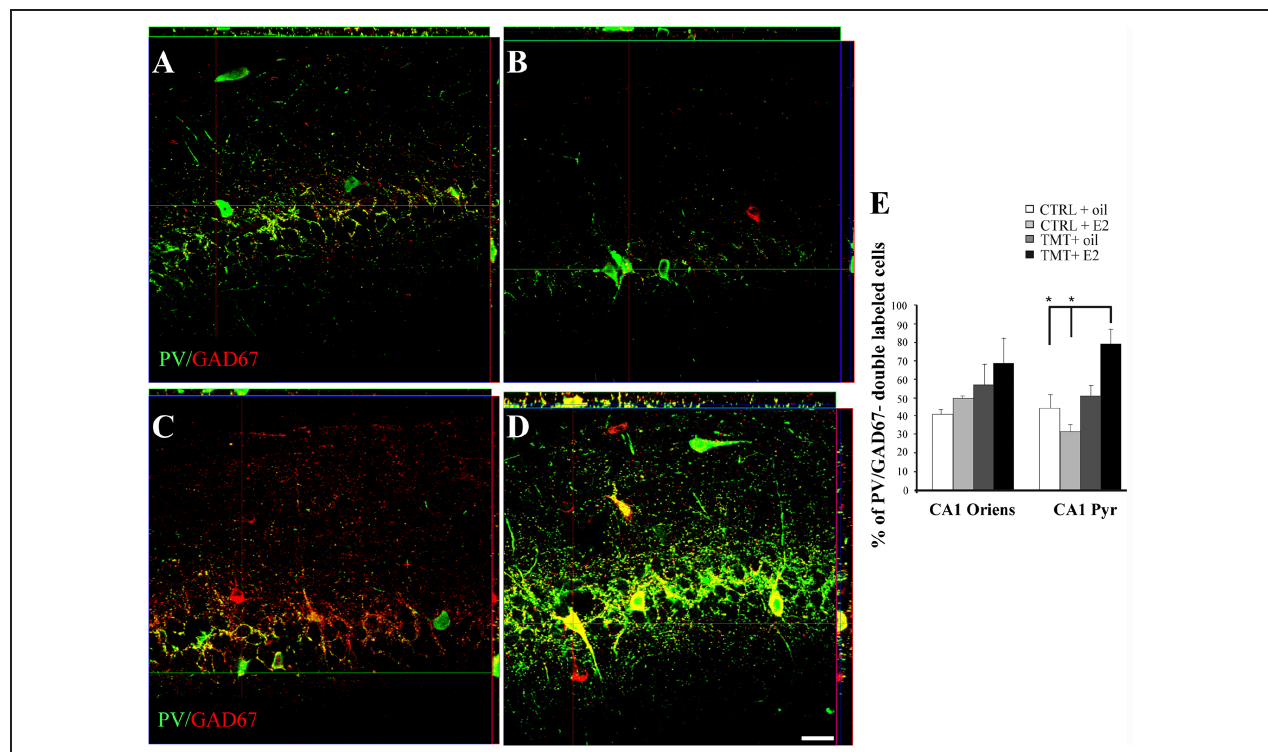
FIGURE 9 | Co-expression of the interneuronal markers parvalbumin (PV) and glutamic acid decarboxylase (GAD) 67 in the CA1 hippocampal region of the different experimental groups. Representative confocal reconstructed orthogonal images, as viewed in the x-z (top) and y-z (right) planes, of hippocampal sagittal sections from the CA1 subfield of CTRL + oil- (A) , CTRL + E2- (B) , TMT + oil- (C) , TMT + E2- (D) treated rats double-labeled for GAD67 (red) and PV (green). The colocalization of the two markers is considerably more evident in TMT + E2 treated animals. Scale bar: 40 μ m. (E) Bar graphs indicating the percentage of PV/GAD67-double-stained cells in CA1 oriens and pyramidal layers. The percentage of PV/GAD67-double-stained cells in CA1 pyramidal layer is higher in TMT + E2-treated rats compared with both control groups. The values are given as means ± SE ( ∗ p <